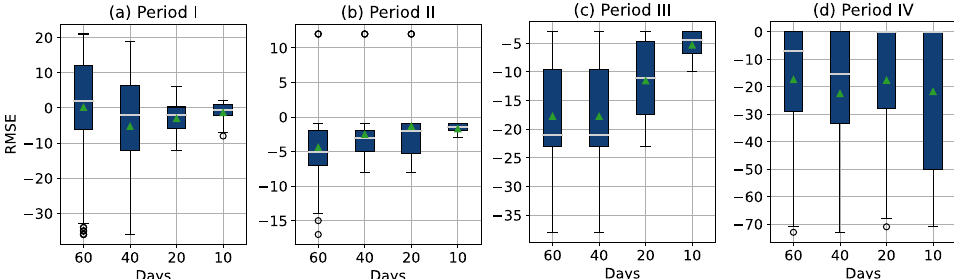
Figure 13. Prediction error for the last 60, 40, 20, and 10 days before threshold is reached, where green triangles represent mean values, for ( a ) period I ([0, 182] days), ( b ) period II ([183, 356] days), ( c ) period III ([356, 541] days), and ( d ) period IV ([542, 730] days).